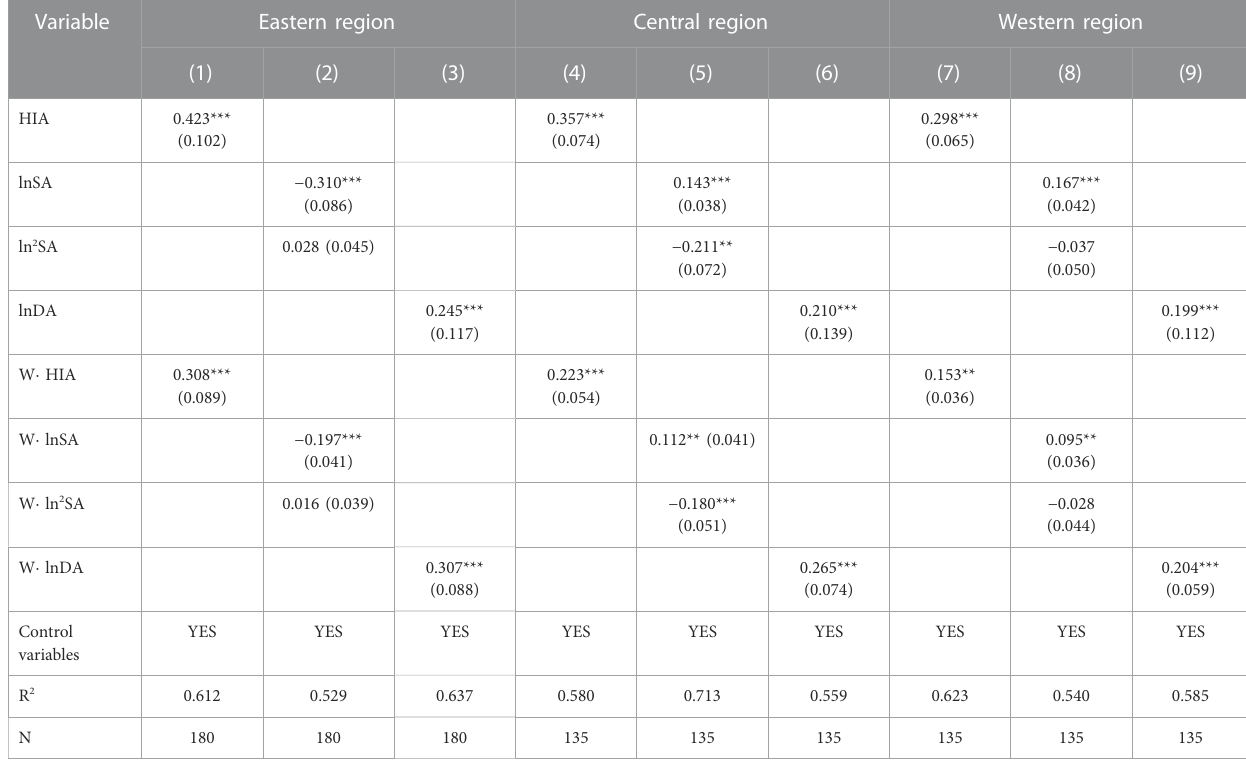
TABLE 7 Results of regional heterogeneity